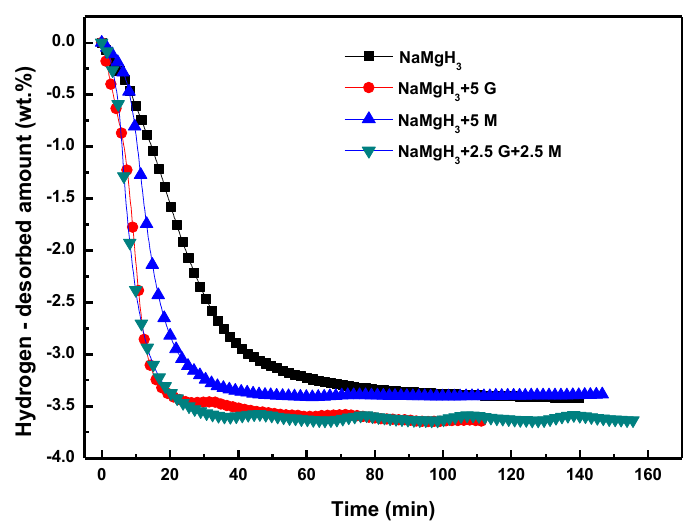
Figure 6. Dehydriding kinetic curves of the NaMgH 3 hydride and the NH-CM composites at 638 K. To illustrate the decomposition mechanism of the NH-CM hydride composites, the XRD patterns of the NaMgH 3 + 2.5 G + 2.5 M sample after dehydriding at different temperatures are shown in Figure 7. With the increase in temperature from 593 K to 638 K, peaks of the NaMgH 3 phase become weakened, and peaks of the NaH phase and Mg phase become strengthened, such results agree well with our previous work for pristine NaMgH 3 hydride reported in [12]. In another word, the decomposition of NaMgH 3 is a two-step reaction: NaMgH 3 → NaH + Mg + H 2 → Na + Mg + 3/2H 2 . The dopping with NM cannot change the decomposition process of NaMgH 3 , but contribute to its dehydriding kinetics.